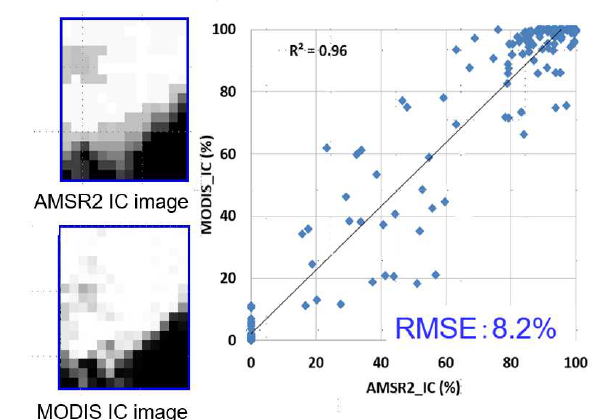
Figure 10. Comparison of MODIS and AMSR2 IC (Bering Sea, March 16, 2016)